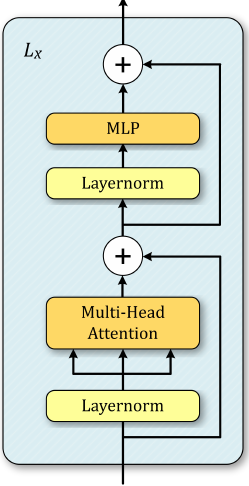
Figure 8. Block diagram of the transformer